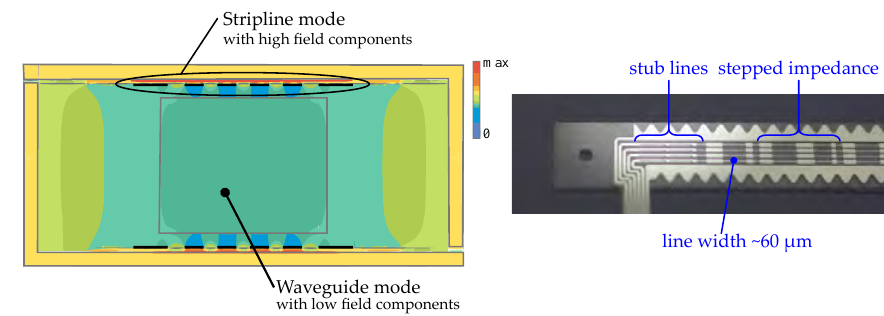
Figure 14. (Left) Field intensity of the guided modes within the dielectrically filled waveguide phase shifter for the case of straight biasing electrodes. Most power is confined in the TEM stripline mode, while nearly no power is in the fundamental TE 10 waveguide mode. (Right) Biasing electrodes with stepped-impedance structures and λ /4-stub lines for strip mode suppression.